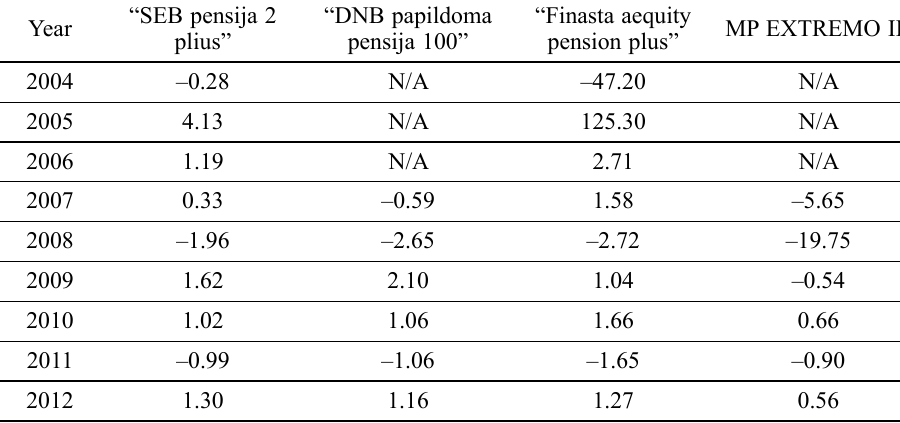
Table 5. Change of equity 3 rd pillar PF Sharpe ratio during